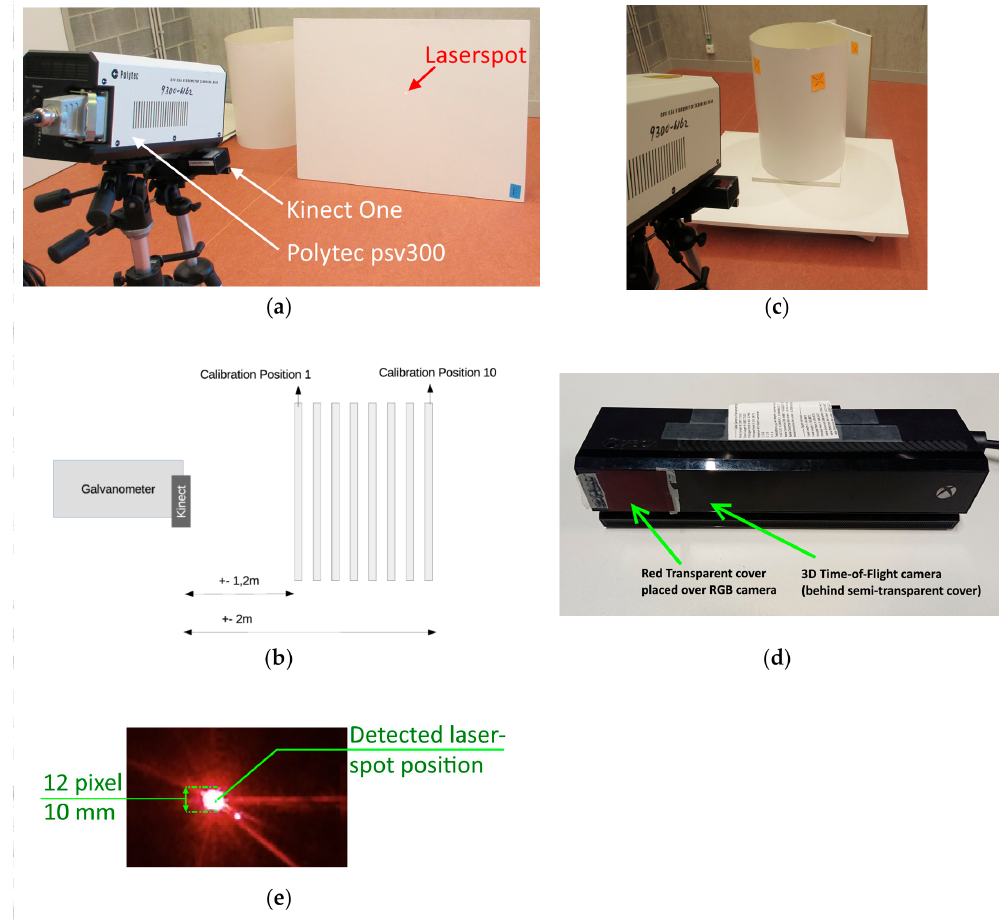
Figure 6. ( a ) Experimental setup for calibrating the system (Polytec PSV 300, Kinect for Xbox One). ( b ) The calibration plate is moved to different positions. ( c ) Experimental setup for comparing the 3D calibration with a standard two-dimensional (2D) calibration. ( d ) Kinect for Xbox One, the RGB camera is covered by a red semitransparent plastic for easier laser spot detection. ( e ) Result of laser spot